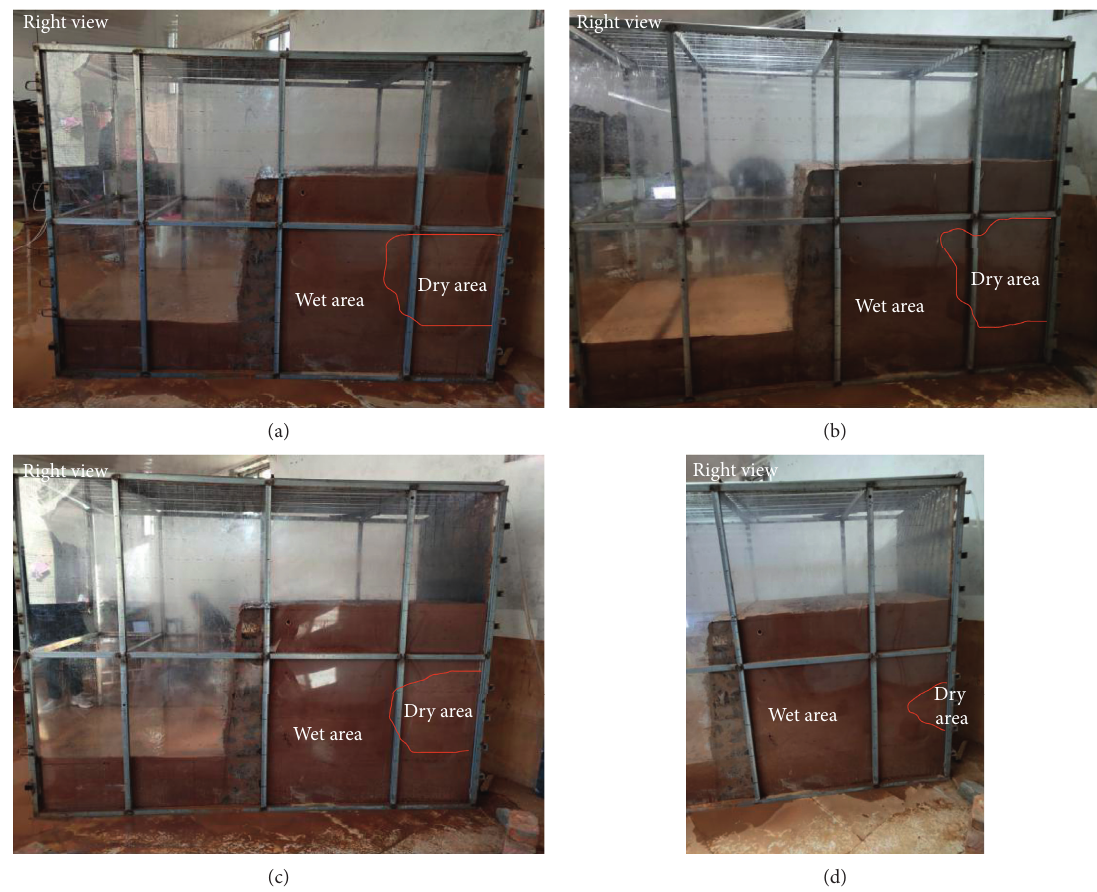
Figure 10: Rainwater infiltration behind the retaining wall within the second year. (a) First rainfall lasted for 120 minutes. (b) Second rainfall lasted for 120 minutes. (c) Third rainfall lasted for 120 minutes. (d) 70 hours after the third